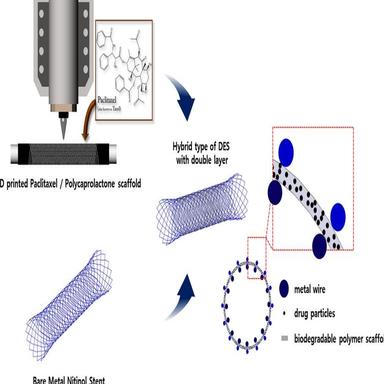
Schematic design of the advanced stent constructed double layer with 3D-printed PTX/PCL scaffold and self-expandable metallic stent.